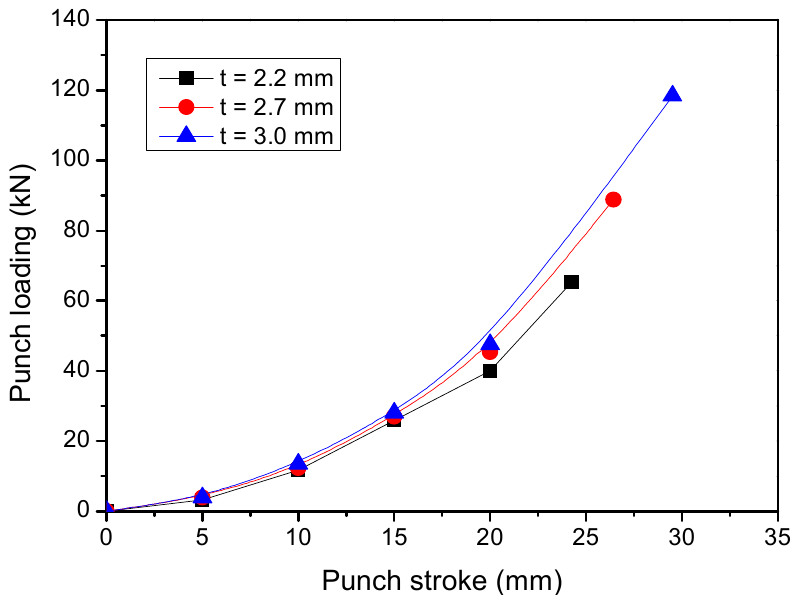
Figure 11. Punch stroke and punch loading curve of AA5754 tailor-welded blanks with different